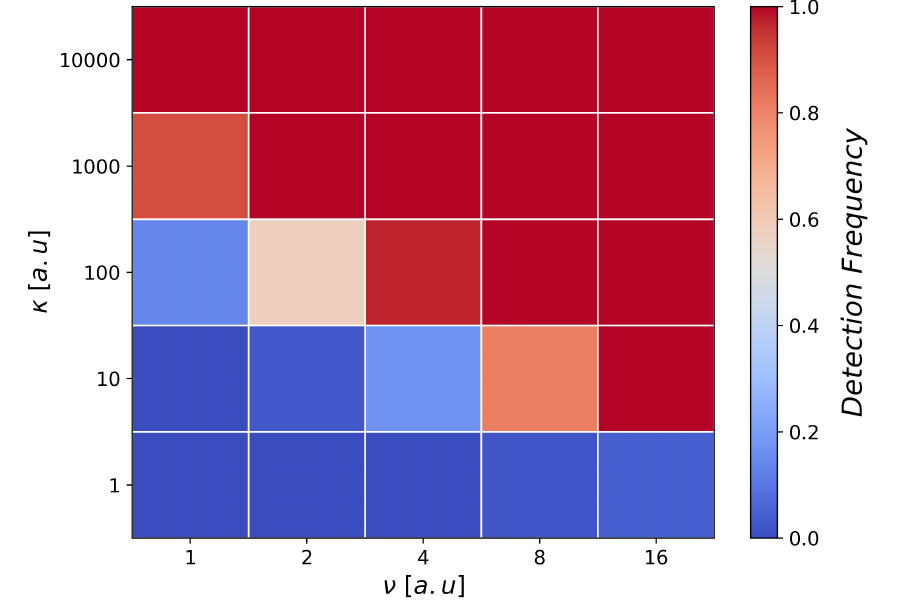
Figure 5. Detection map for the 25 combinations of κ and ν values, where colors represent the detection frequency (ranging from 0 to 1).